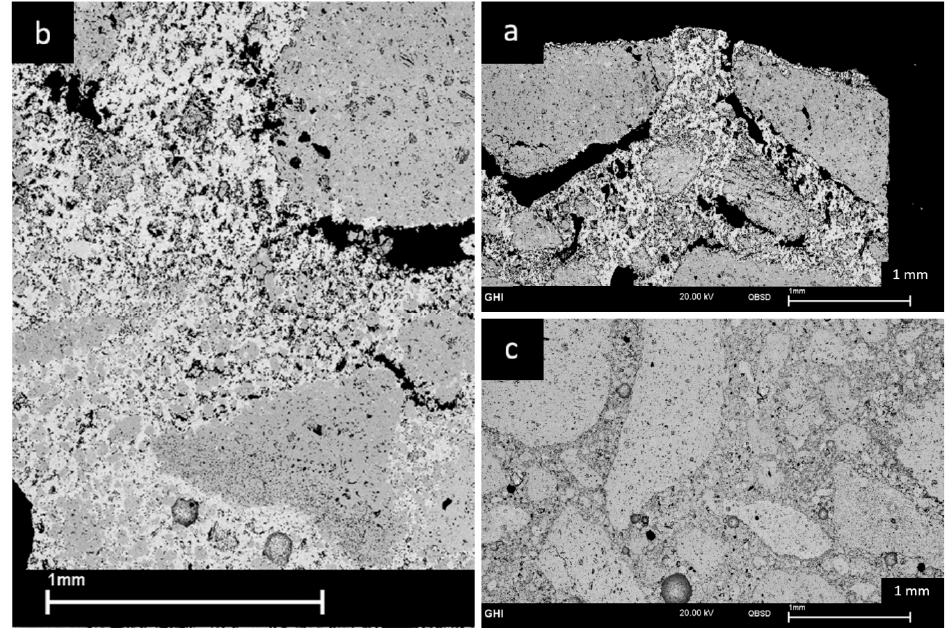
Figure 8. Backscattered SEM image of ( a ) corroded Zone, ( b ) infiltrated matrix, ( c ) uncorroded zone of the LCC sample after corrosion with blast furnace slag, revealing the infiltration, reaction and debonding mechanisms.